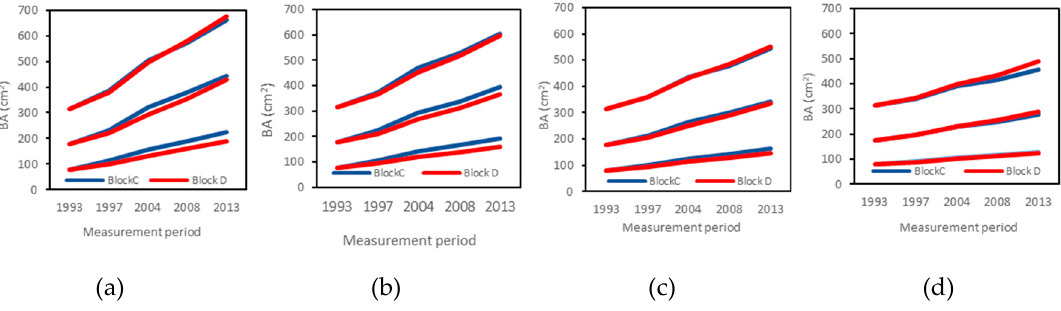
Figure 5. BA (cm 2 ) projections for interior Douglas-fir growing in Blocks C and D starting in 1993 at 10 cm DBH (lowest set of lines), 15 cm DBH (middle set of lines), and 20 cm DBH (highest set of lines) under ( a ) no competition, ( b ) 10th percentile of competition, ( c ) 50th percentile of competition, and ( d ) 90th percentile of competition.